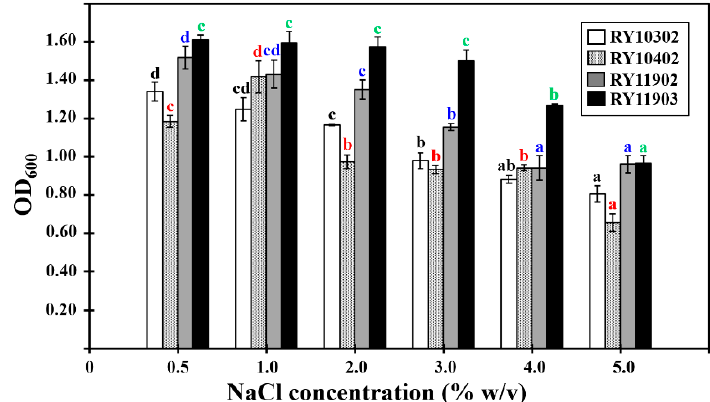
Figure 4. Effect of salinity on the growth of four dye-decolorizing bacteria expressed as optical density measure at 600 nm. All experiments were performed in triplicate. Different letters with the same color on the top of SD bars indicate significant differences ( p < 0.05).